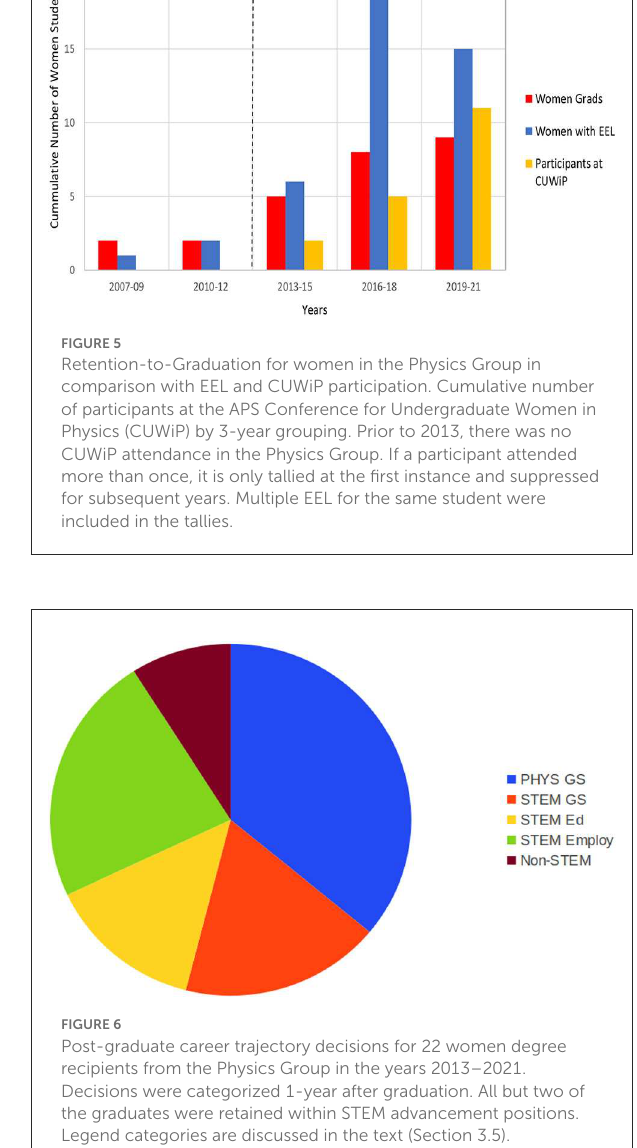
average above 5.0 (c.f. Figure 1). Since immediately after graduation